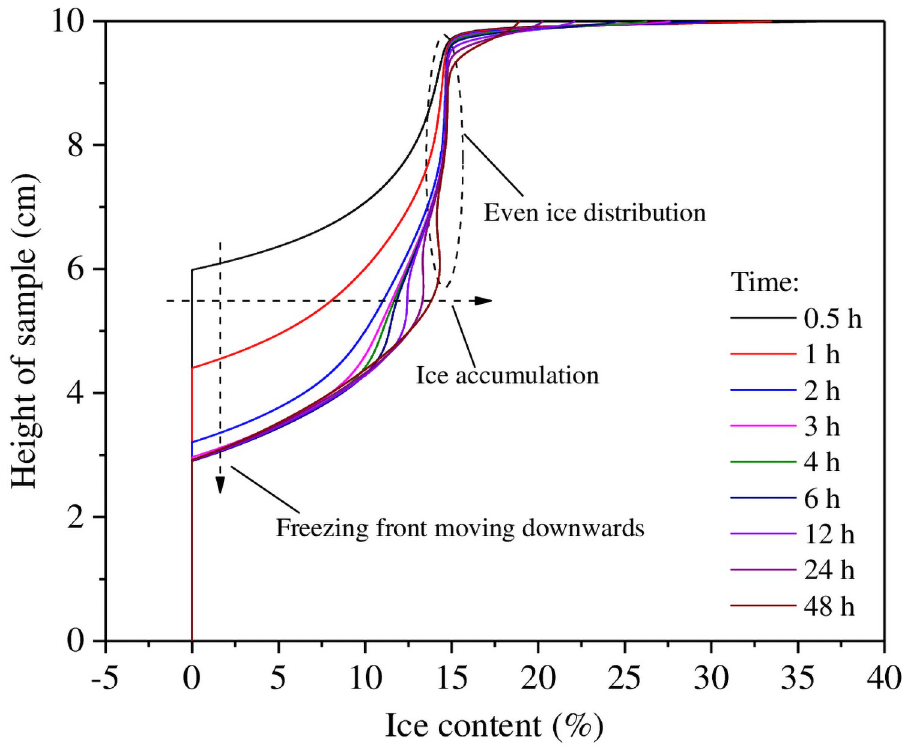
Fig 7. The calculated rate of ice accumulation for the experiment with a boundary temperature of −